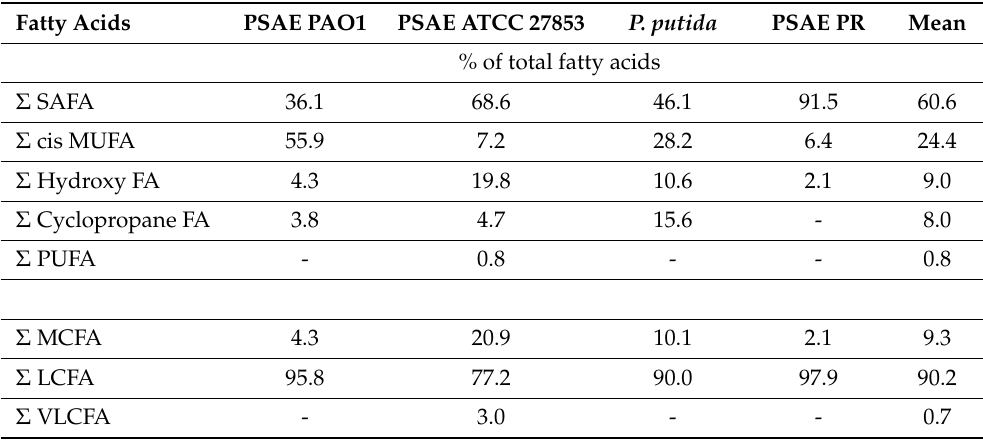
Table 2. Fatty acid methyl ester presence in samples from P. aeruginosa PAO1, P. aeruginosa ATCC 27853, P. putida , and P. aeruginosa polyresistant bacteria based on the percentile peak area. The bacteria were cultivated at 37 ◦ C on agar media. Fatty acids were extracted one day following inoculation. The relative standard deviation is less than 2%. Experiments were performed in triplicates. Fatty Acids PSAE PAO1 PSAE ATCC 27853 P. putida PSAE PR Mean % of total fatty acids